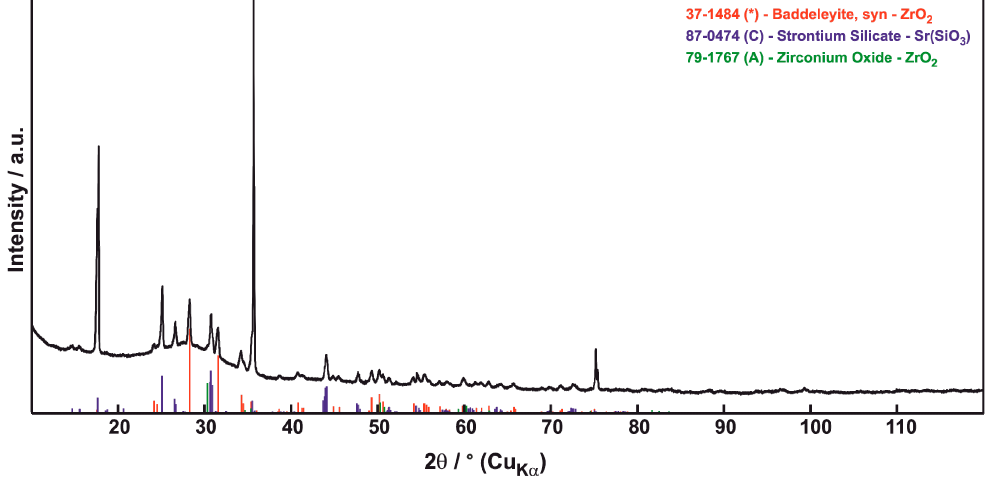
Figure 5. XRD patterns of the sample “4 h”.